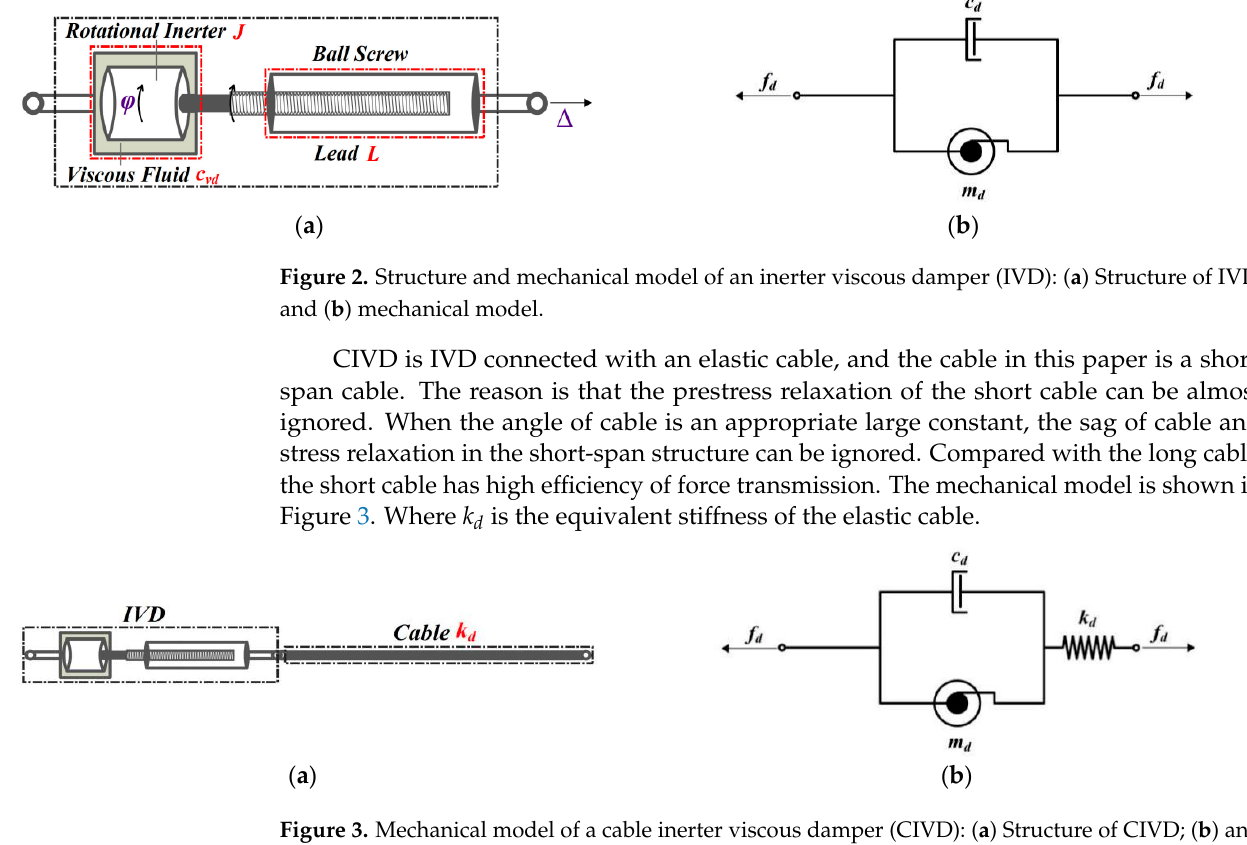
Figure 3. Mechanical model of a cable inerter viscous damper (CIVD): ( a ) Structure of CIVD; ( b ) and mechanical model.